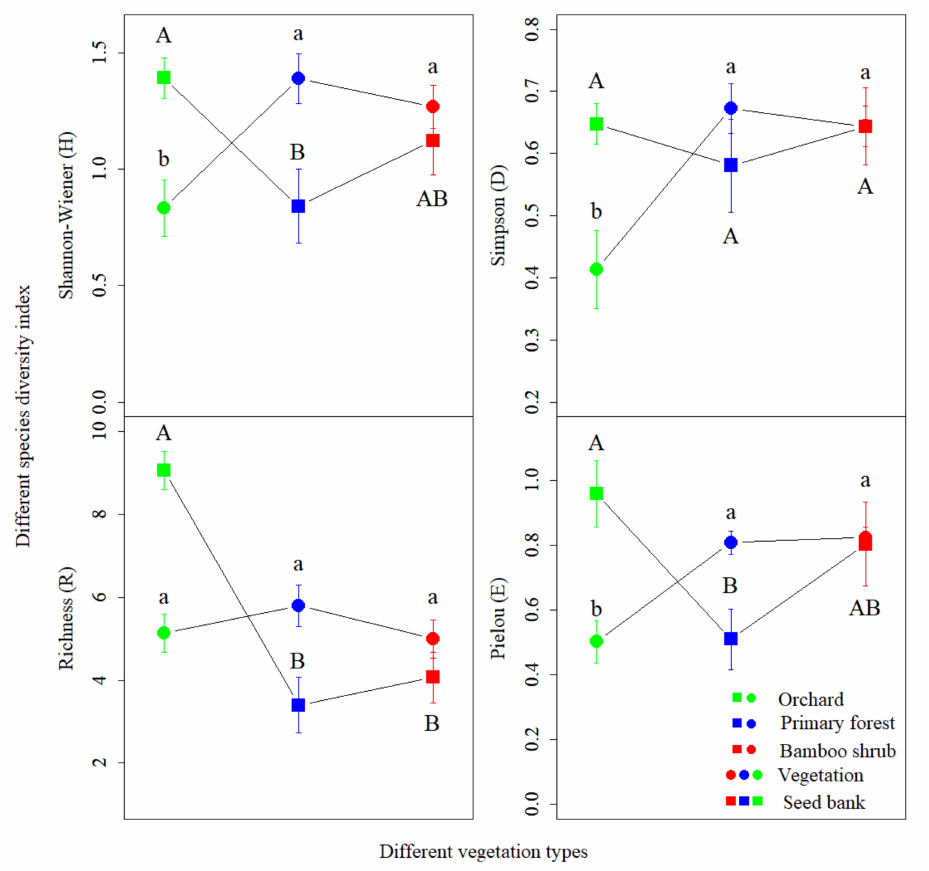
Figure 5. Species diversity index of vegetation and soil seed bank in each vegetation type (mean ± standard error, n = 15). Different capital letters indicate significant differences (ANOVA, LSD test, p < 0.05): lowercase letters for aboveground vegetation and uppercase letters for soil seed